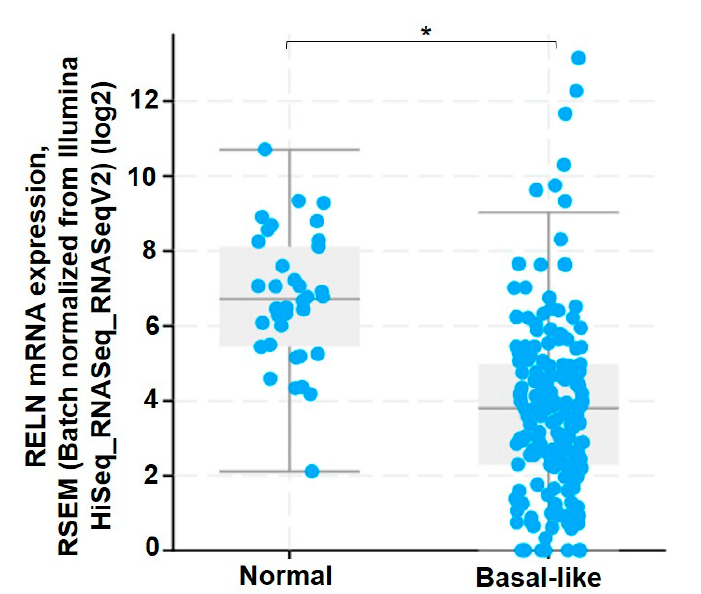
Figure 3. RELN mRNA expression is reduced in basal-like breast cancer. Plot shows RELN gene expression in samples from normal breast tissue versus samples of basal-like subtype of breast cancer, obtained from the Breast Invasion Carcinoma data (TCGA, PanCancer Atlas, cBioPortal); * p = 6.77 × 10 − 12 See Materials and Methods for details of analysis.